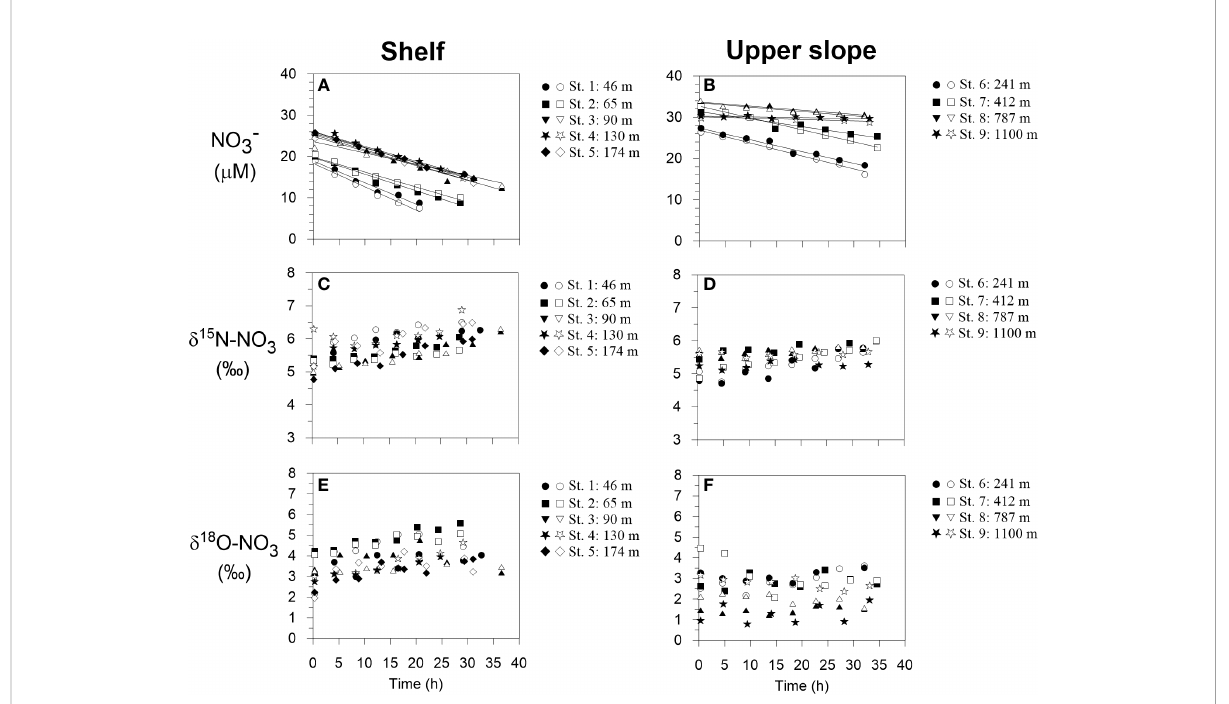
FIGURE 2 Benthic chamber incubation results for NO 3- on the shelf and upper slope. (A, B) NO 3- concentrations with linear regression curves from which the fl uxes are calculated, (C, D) d 15 N-NO 3 and (E, F) d 18 O-NO 3 . Filled and open symbols correspond to chamber 1 and 2 during each BIGO lander deployment,